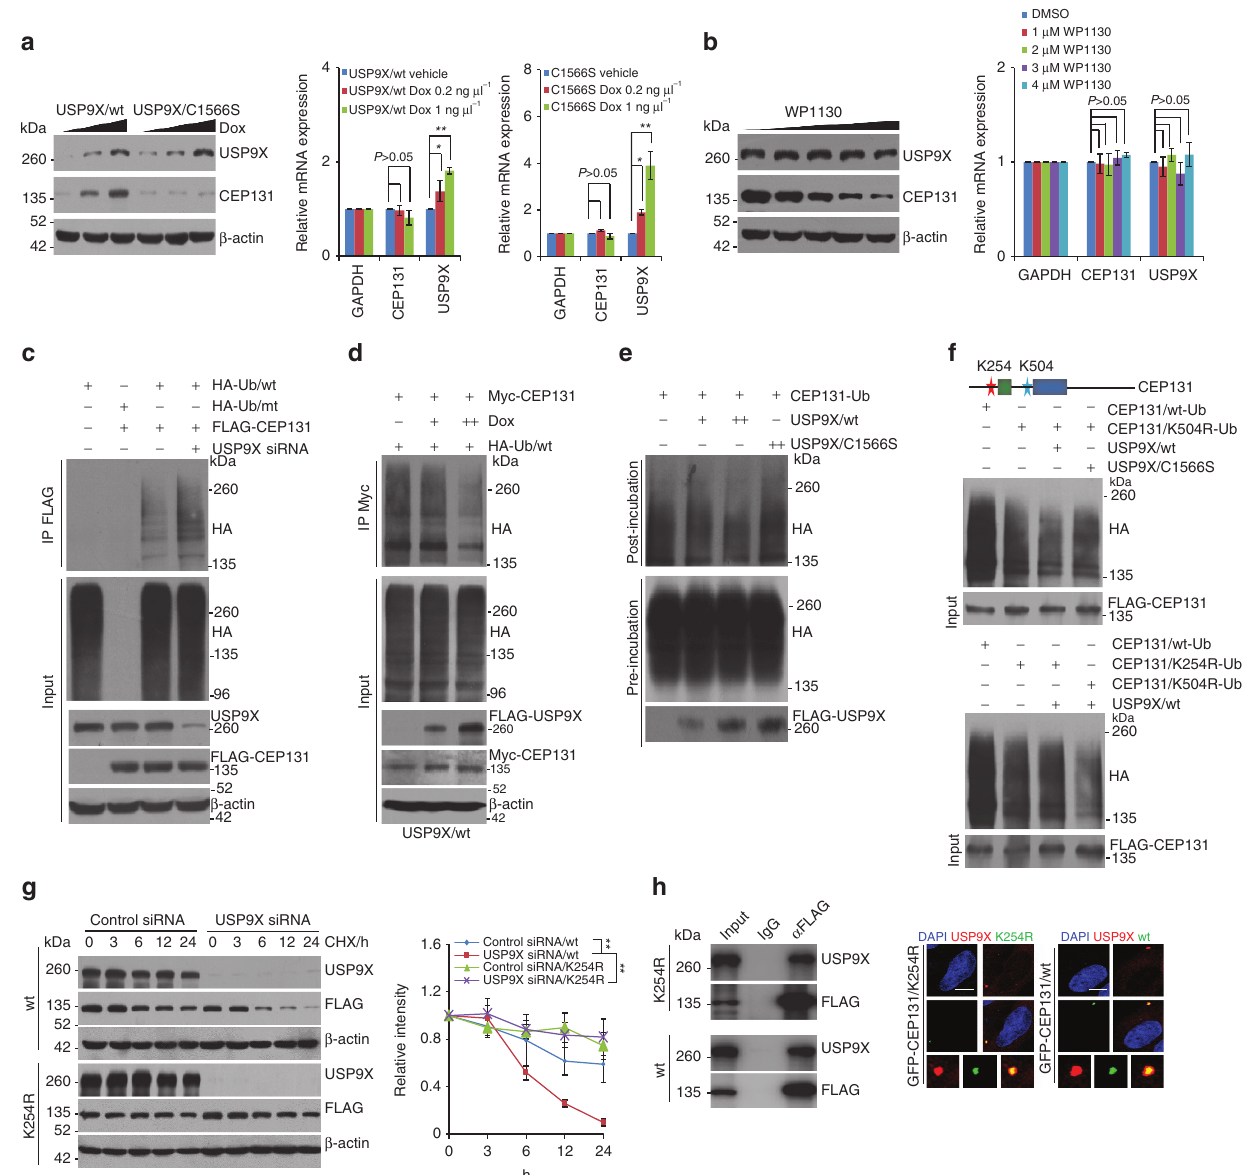
Figure 4 | USP9X promotes CEP131 deubiquitination. ( a ) MCF-7 cells with Dox-inducible expression of FLAG-USP9X/wt or FLAG-USP9X/C1566S were cultured in the absence or presence of increasing amounts of Dox. Cellular extracts and total RNA were collected and analysed by western blotting (left panel) and qRT–PCR (right panel), respectively. Each bar represents the mean ± s.d. for biological triplicate experiments. * P o 0.05, ** P o 0.01, one-way ANOVA. ( b ) MCF-7 cells were cultured in the absence or presence of WP1130 as indicated. Cellular extracts and total RNA were collected and analysed by western blotting (left panel) and qRT–PCR (right panel), respectively. Each bar represents the mean ± s.d. for biological triplicate experiments. P values were determined by one-way ANOVA. ( c ) MCF-7 cells stably expressing FLAG-CEP131 were co-transfected with control siRNA or USP9X siRNA together with HA-tagged wild type ubiquitin (Ub/wt) or a ubiquitin mutant (Ub/mt) with all lysine residues replaced by arginine as indicated. Cellular extracts were prepared for co-immunoprecipitation assays with anti-FLAG followed by IB with anti-HA. ( d ) HeLa cells with Dox-inducible expression of USP9X/wt were co-transfected with Myc-CEP131 and HA-Ub/wt and cultured in the absence or presence of Dox. Cellular extracts were prepared for co-immunoprecipitation assays with anti-Myc, followed by IB with anti-HA. ( e ) In vitro deubiquitination assays with HeLa cells-purified FLAG-tagged CEP131-Ub and USP9X/wt or USP9X/C1566S. ( f ) In vitro deubiquitination assays with HeLa cells-purified FLAG-tagged CEP131/K254R-Ub or CEP131/ or USP9X siRNA. Cells were treated with CHX and harvested at the indicated time followed by western blotting analysis. Intensity of each band from biological triplicate experiments was quantified by densitometry with the Image J software with b -actin as a normalizer. Each bar represents the mean ± s.d. for biological triplicate experiments. ** P o 0.01, two-way ANOVA. ( h ) Co-immunoprecipitation (left panel) and microscopy analysis (right panel) of the association and co-localization of USP9X with CEP131/wt or CEP131/K254R. Representative images from biological triplicate experiments are shown. Scale bars, 10 m